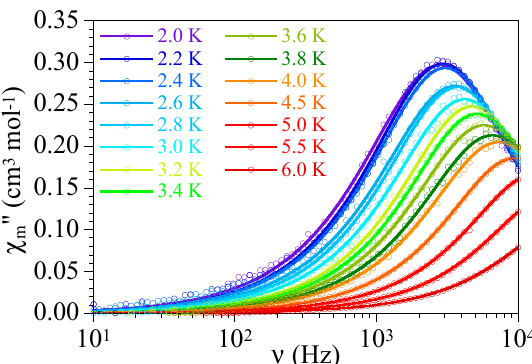
Figure 6. Frequency dependence of the in-phase AC susceptibility for 1 with an applied DC field of 800 Oe at different temperatures. Solid line is the best fit to the Debye model (Equation (2)).